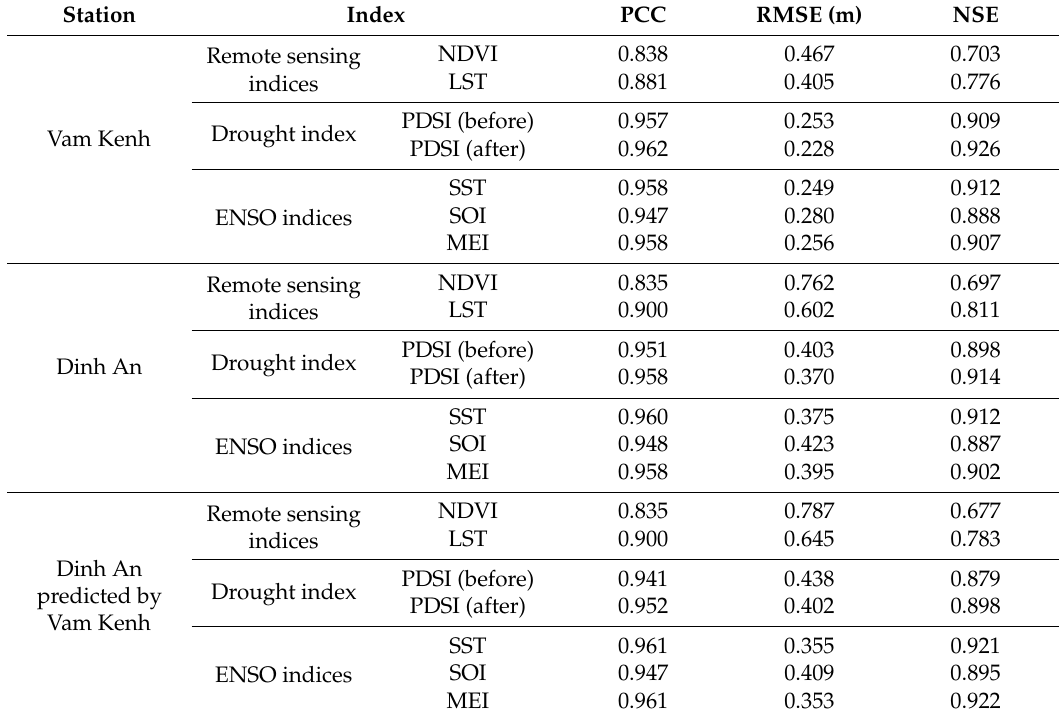
Table 2. Internal and external assessment of observed water levels and reconstructed water levels derived from various indices at the Vam Kenh, Dinh An and Dinh An station predicted by Vam Kenh. The third part means we used Vam Kenh data and various indices to reconstruct the water level for Dinh An station. PDSI (before) represents using the PDSI only to reconstruct water levels, while the PDSI (after) stands for ENSO-assisted